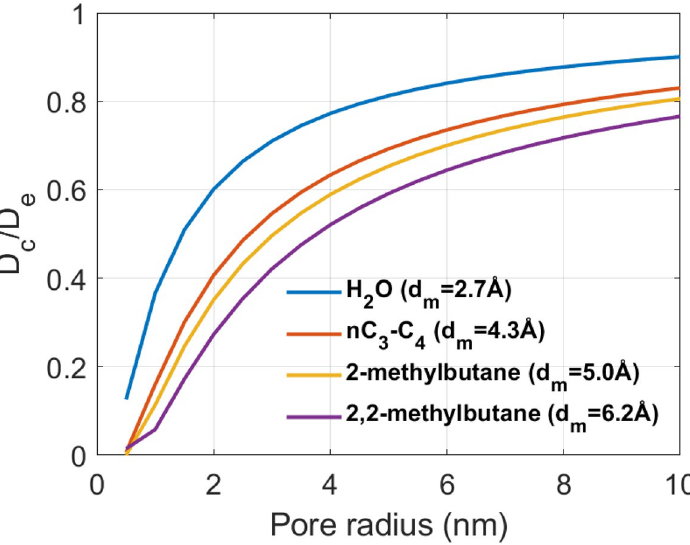
Figure 11. Restricted diffusion versus pore size for molecules of different